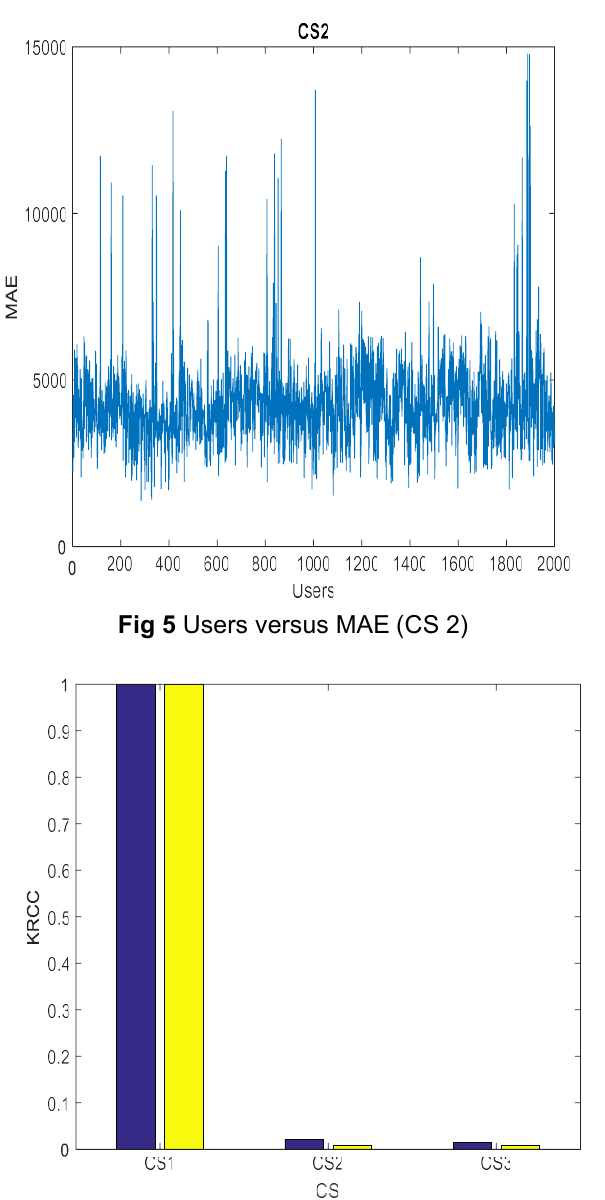
Fig 5 Users versus MAE (CS 2) Fig 6 Users versus MAE (CS 3)